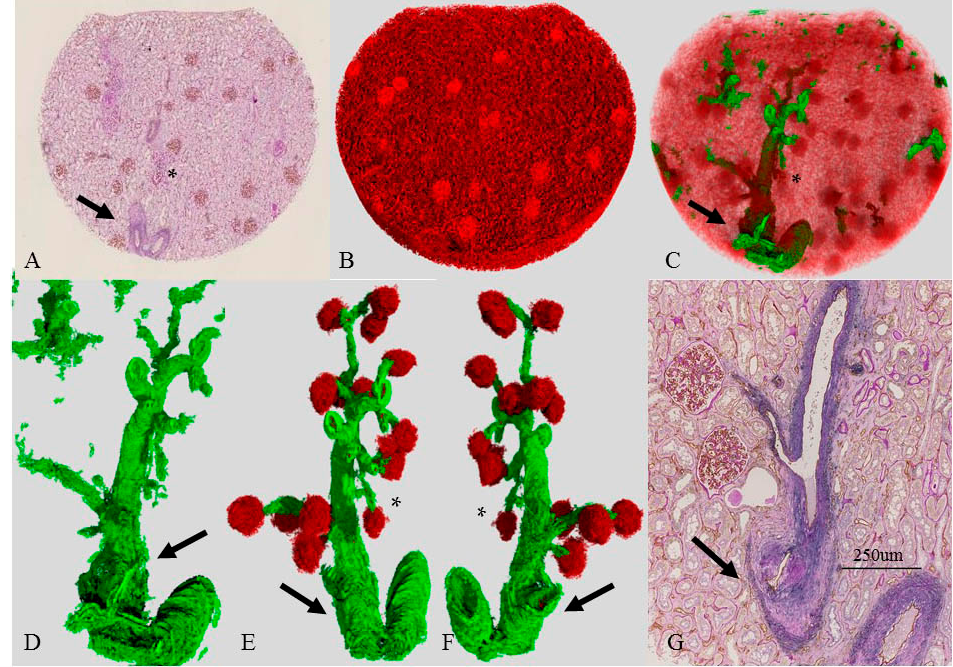
Figure 3. Vascular tree with decreased glomeruli (case 3). ( A ) Original 2D image of the section double-immunostained with anti-CD34 ( brown ) and anti-SMA ( blue ) and then PAS stain; ( B ) 3D reconstructed image of CD34. Glomeruli are round. Capillaries resemble a mesh network ( red ). Density of glomeruli is low; ( C ) 3D image of the vascular tree; ( D – F ) A single vascular tree with ( E , F ) or without ( D ) associated glomeruli; Red and green represent CD34 and SMA, respectively. All of the arteries show a regular SMA distribution and smooth surface. Arteries run straight. The branching angles of the afferent arterioles are sharp; ( G ) corresponding 2D image double-stained for CD34 and SMA with PAS stain. The diameter of the proximal interlobular artery is wide; and ( A , G ) corresponding 2D view reveals marked intimal fibrosis and medial atrophy; luminal area is preserved ( A ); and the arrow in ( G ) points to a bifurcation site and shows irregular intimal hyperplasia. Although the lumen seems narrow, the consecutive specimen reveals a large lumen, as seen in ( A ). The arrow and asterisk (*) correspond to the same symbols ( A , C – G ) and represent the interlobular artery and the atubular glomerulus in Figure 5, respectively.